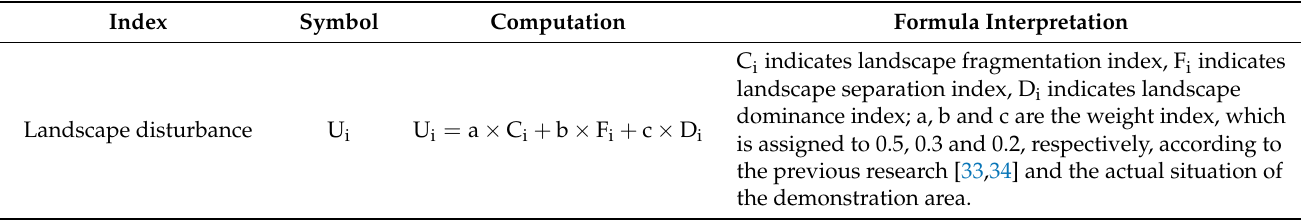
Table 2. The related calculation formulas for landscape disturbance